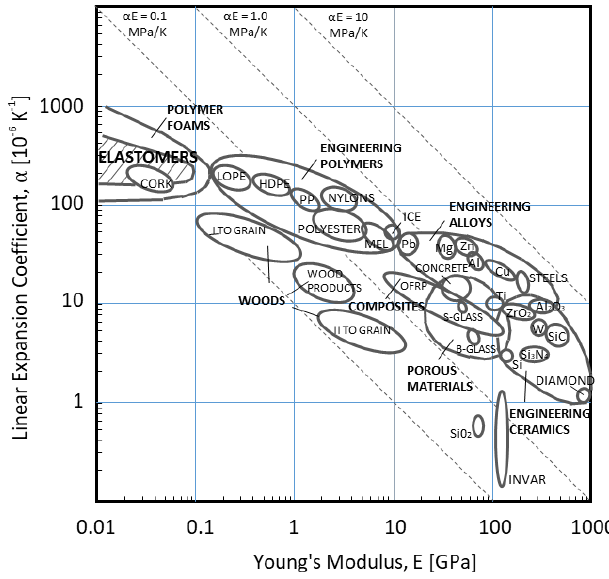
Figure 11. Expansion coefficient for different materials, based on [40].